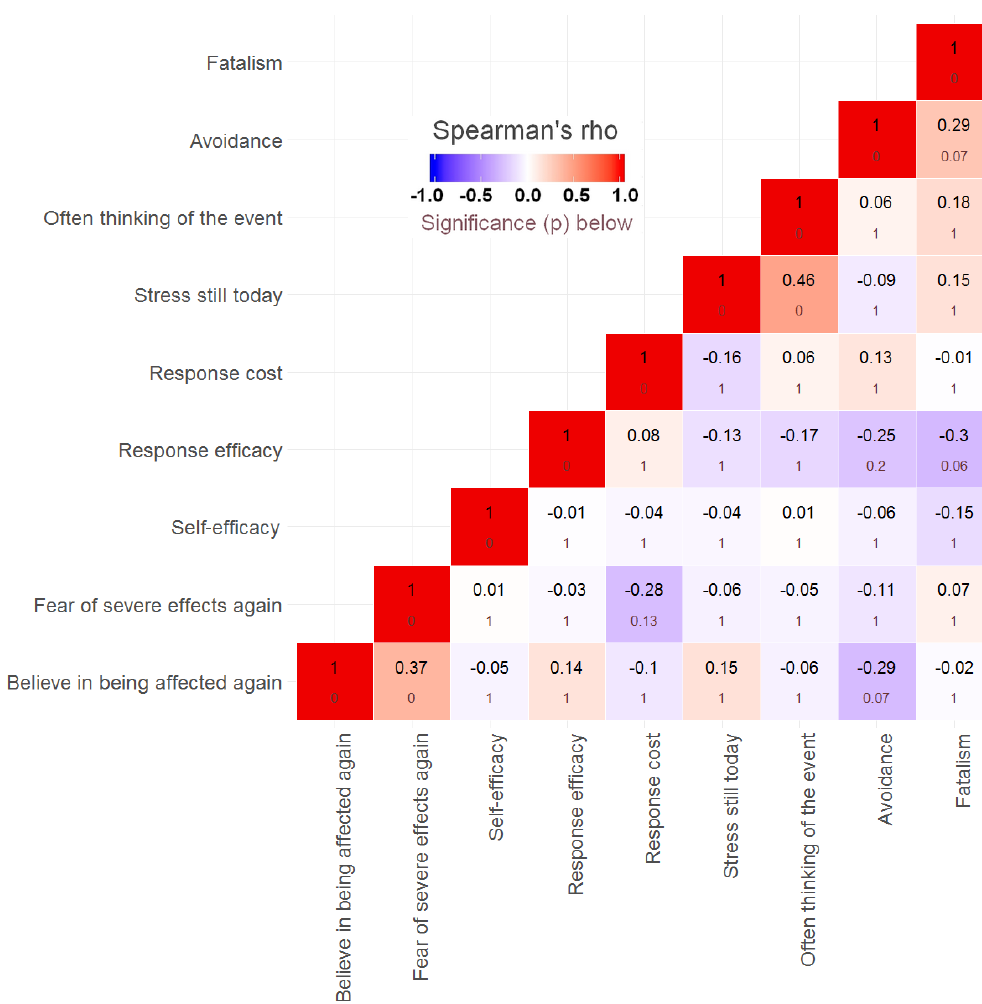
Figure A2. Correlation table of single psychological variables for strong flash